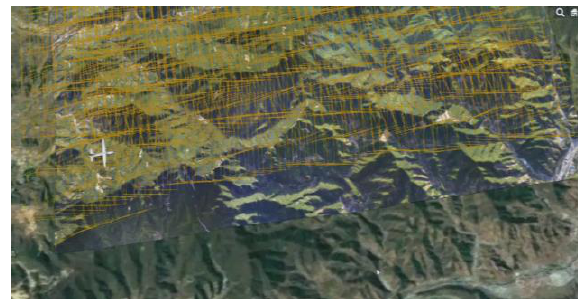
Figure 11. Dynamic visualization of the footprints Figure 12 shows the result of real-time direct georeferencing. Two video cameras (visual and infrared) mounted on a fix-wing UAV capture high-resolution video during a flight in 2017. The video and POS data are directly transmitted to the ground station via communication. The utility programs on the server side receive the POS data and transform the coordinates and construct the rotation matrix R accordingly. Then the footprints of the video are generated and dynamically overlaid on the textured DEM. The blue footprints correspond to the visual camera and the red ones correspond to the infrared camera. The infrared footprints can be used to locate the burning point and measure burning area, which is very important for forest fire fighting.